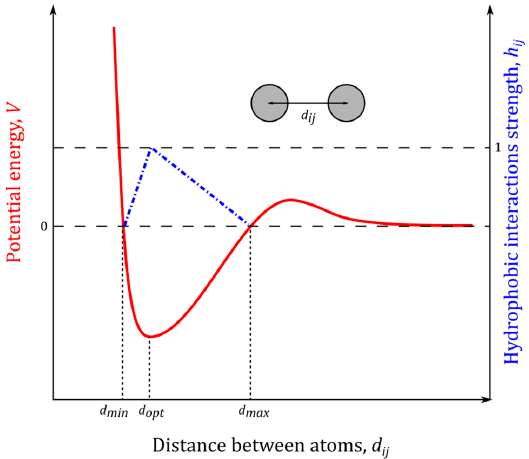
Figure 19. An example of the simplified knowledge-based potential extracted from the high-resolution X-ray structure in the PDB files. The interaction range consists of d min , d opt , and d max as shown.